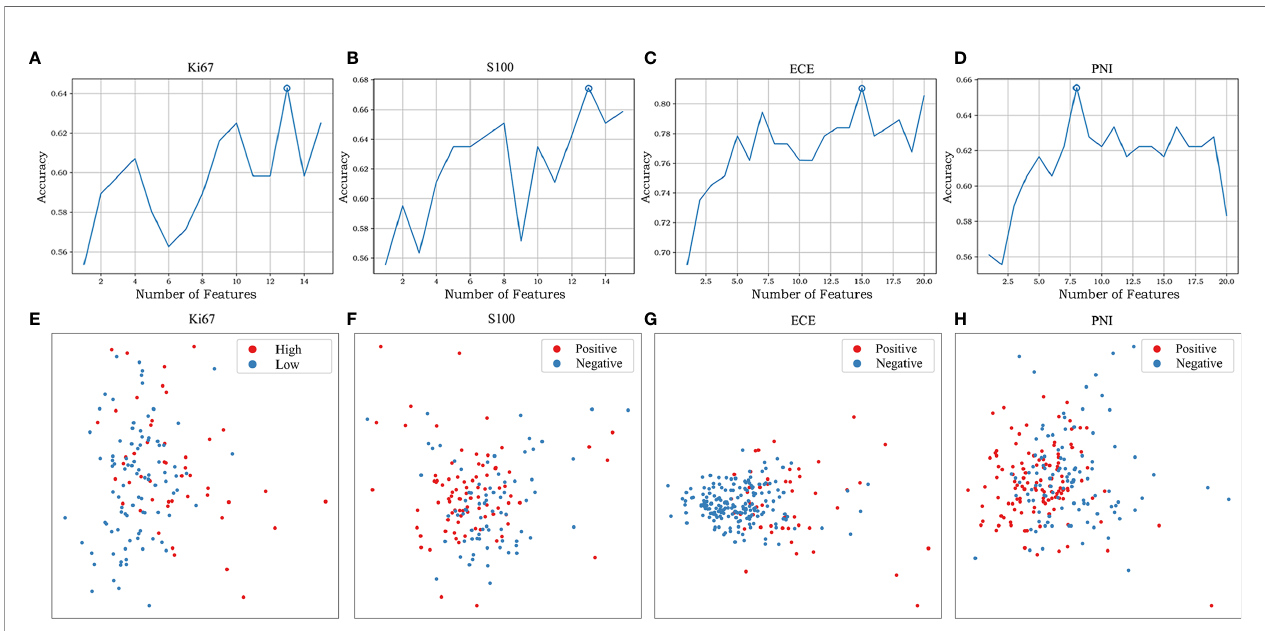
FIGURE 2 | The feature selection of RFE-RF and the distribution of different cases on PCA. RFE-RF (A – D) was applied to fi nd the best feature combination step by step, and the combinations with the highest accuracy will be incorporated into the models. PCA (E – H) showed the selected features could satisfactorily distinguish the division of cases in each group intuitively according to their feature values. The corresponding fi gures for SM are shown in Supplementary Figure S2